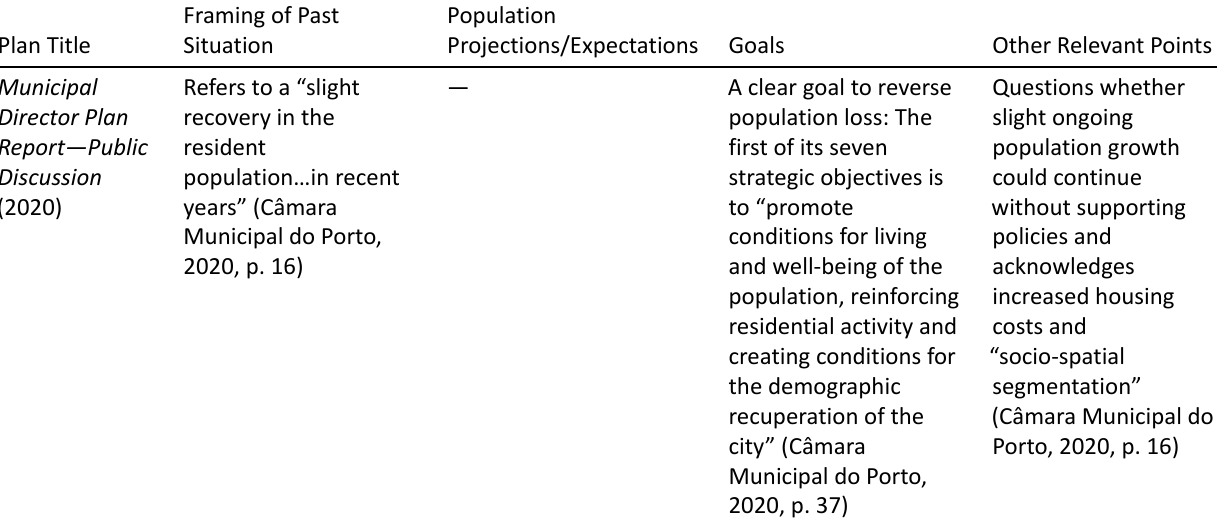
Table 2. (Cont.) Approaches to urban shrinkage as seen in municipal planning documents from Buffalo and